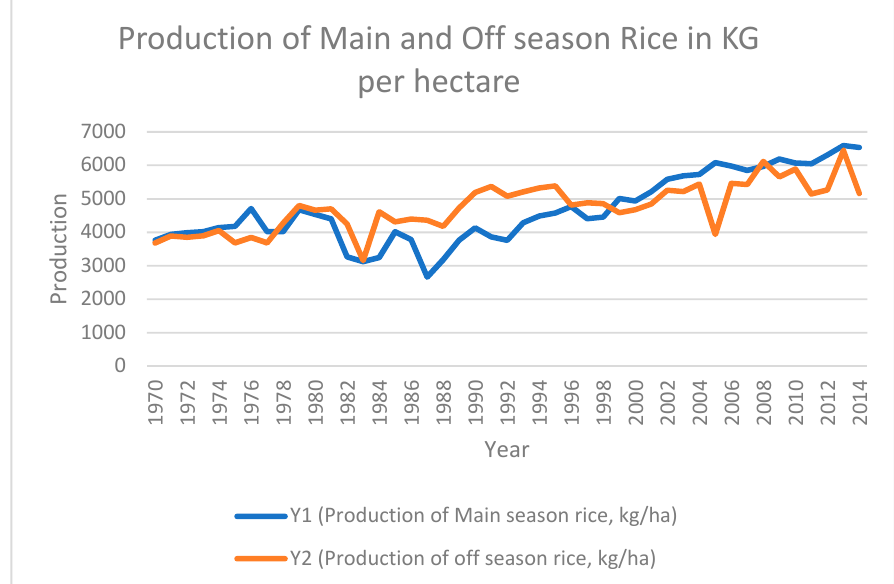
Figure 2. Production of rice in main and off seasons, 1970–2014.